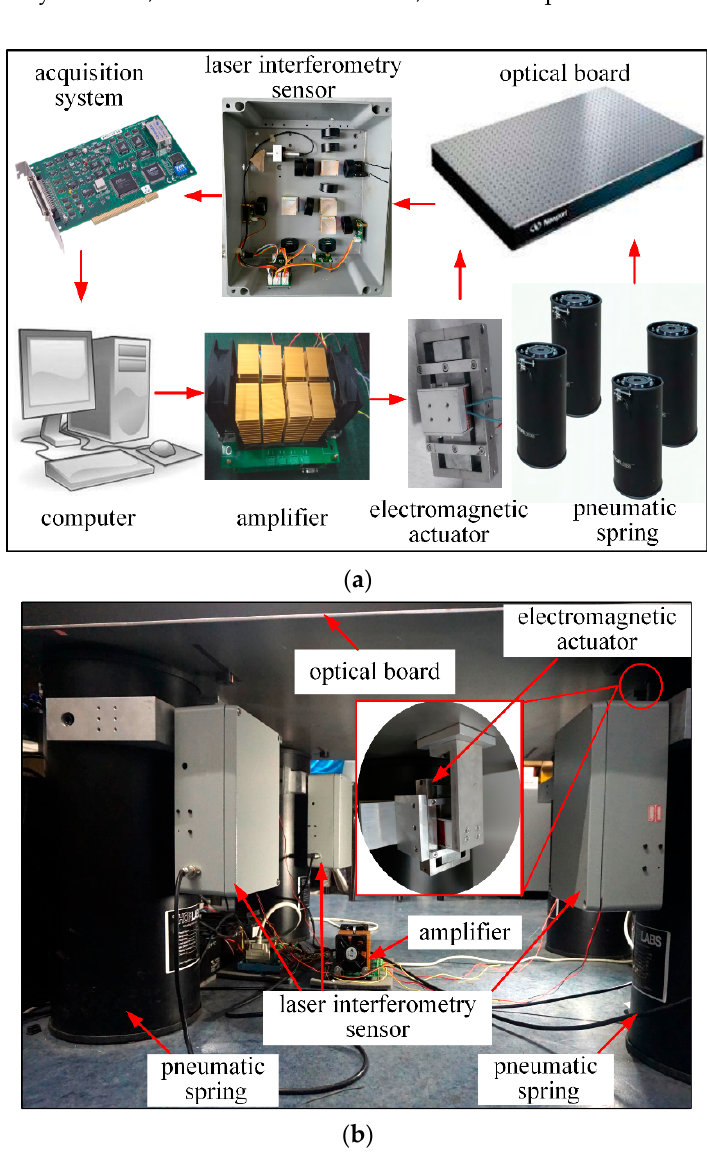
Figure 16. Experimental setup for the EANSG method validation: ( a ) sketch of the experimental setup and ( b ) a photo of the experimental setup.